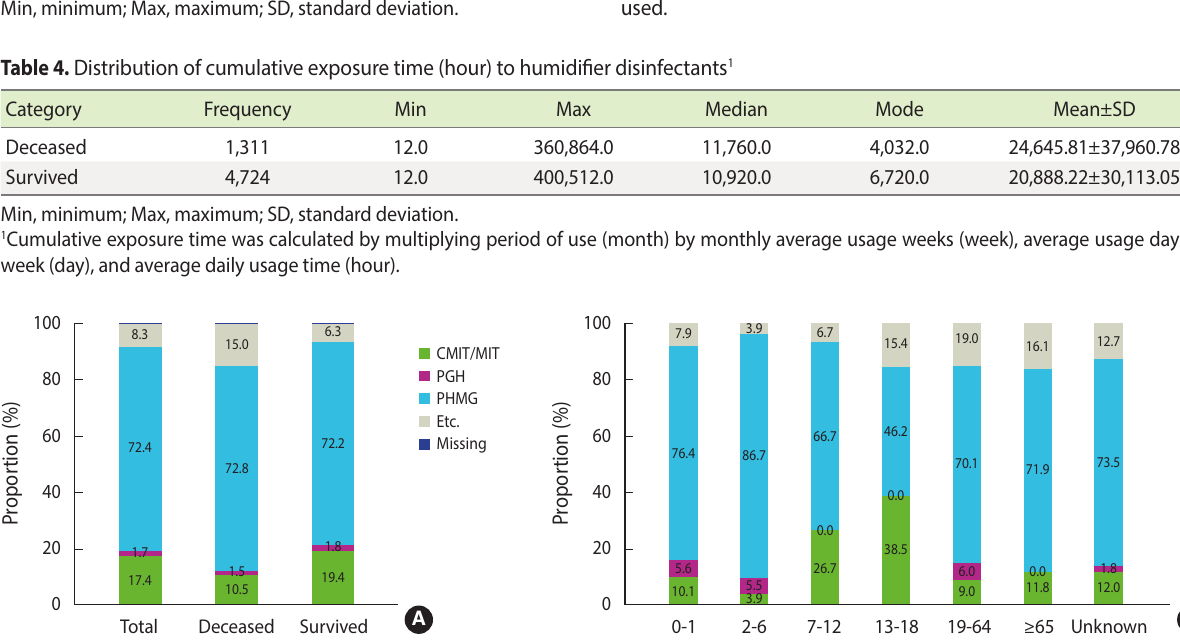
Figure 2. Distribution of the number of humidifier disinfectants